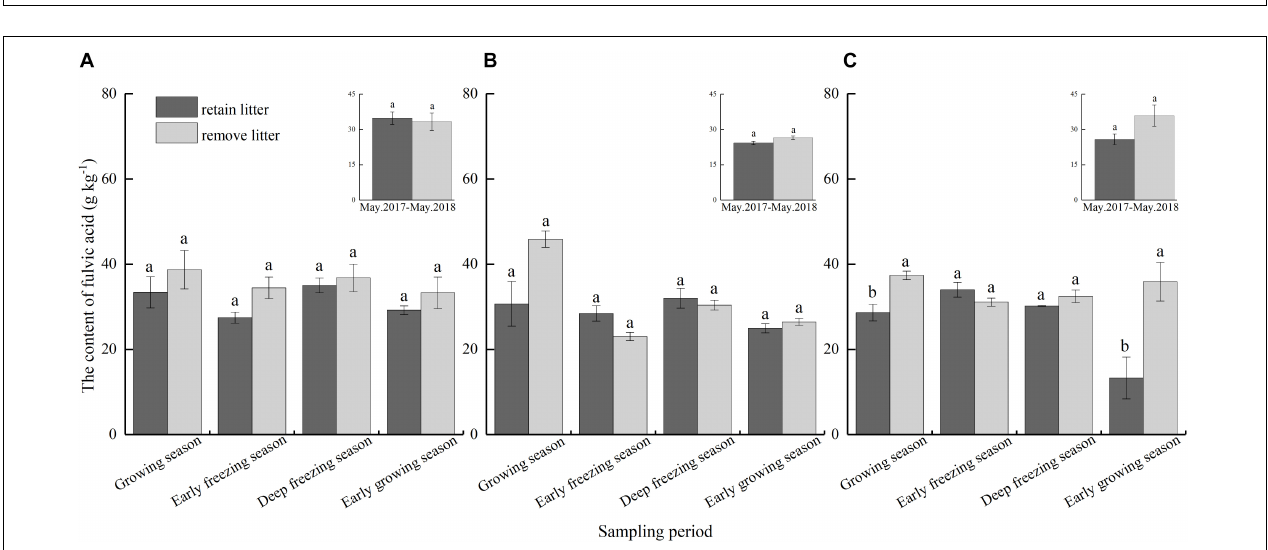
FIGURE 4 | Content of soil humic acid as affected by litter removal at different periods in the (A) coniferous forest, (B) mixed forest, and (C) broadleaved forest. The histograms show the averaged values over 1 year. The presented content values are the means of 3 observations; the error bars represent standard errors. Lowercase letters represent significant differences in the contents of total extracted humus between the different litterfall treatments.